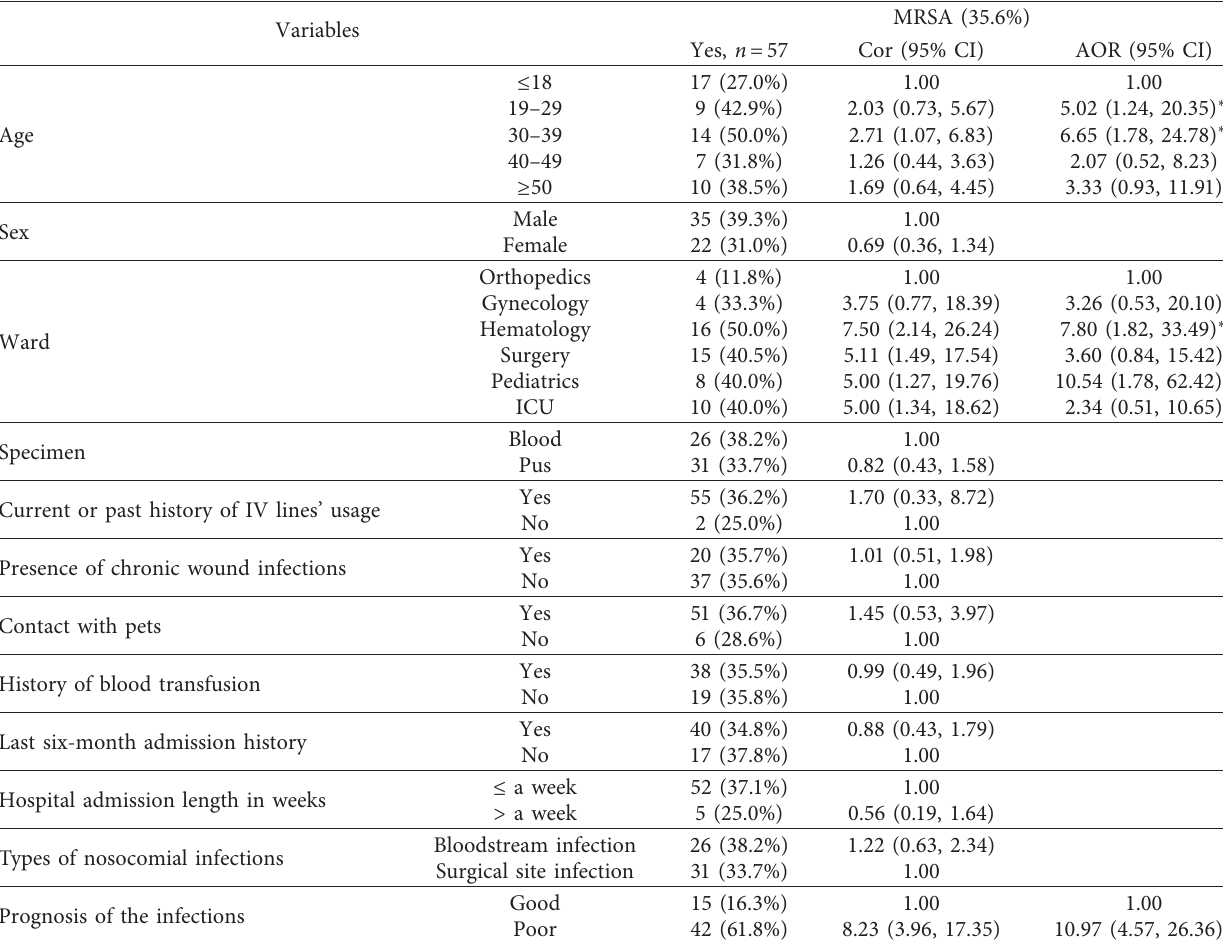
Table 2: Factors associated with MRSA among patients admitted to Tikur Anbessa Specialized Hospital, Addis Ababa, Ethiopia, from January 2018 to January 2019 ( n �